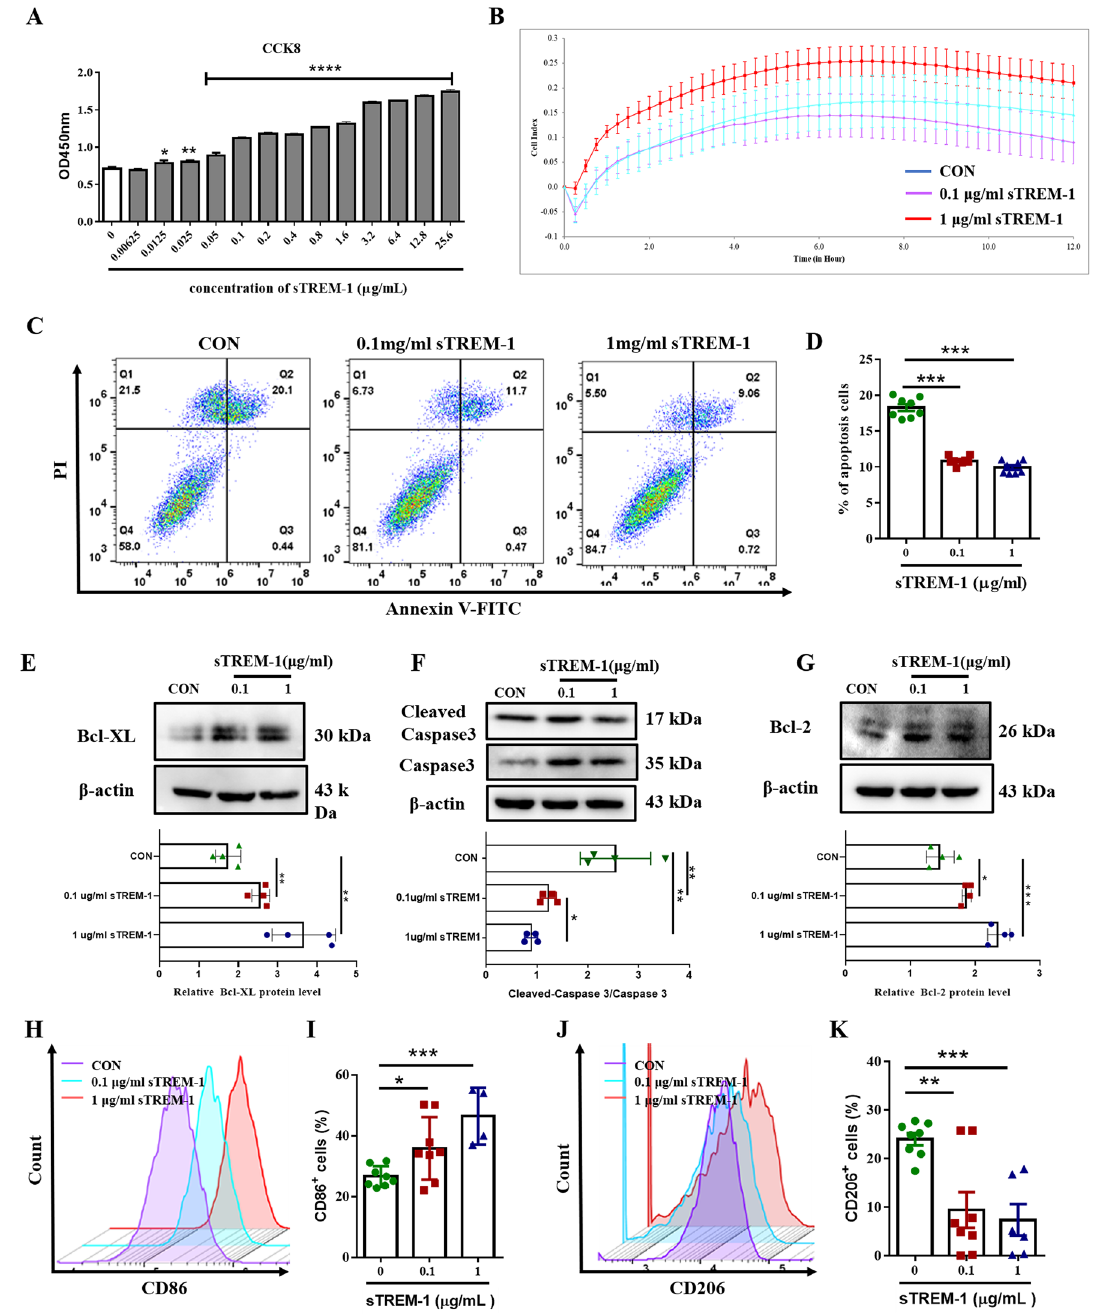
Figure 4. sTREM-1 promotes the activation of BV2 cells in vivo . (A) CCK-8 was used to detect the cytotoxicity of sTREM-1 on BV2 cells. (B) RTCA was used to detect the effect of sTREM-1 on the proliferation of BV2 cells in each treatment group. (C) Representative images of the apoptotic levels of BV2 cells in each treatment group were detected by flow cytometry. (D) The percentage of early apoptotic (Annexin V + PI + ) cells in each treatment group. (E) Representative western blot images and quantitative analysis of Bcl-XL protein expression levels of BV2 cells in each treatment group. (F) Representative western blot images and quantitative analysis of caspase-3 protein expression levels of BV2 cells in each treatment group. (G) Representative western blot images and quantitative analysis of Bcl-2 protein expression levels of BV2 cells in each treatment group. (H) Representative images of M1 phenotype (CD86 + ) in BV2 cells by flow cytometry detection. (I) Quantitative analysis of the proportion of CD86 + BV2 cells in each treatment group. (J) Representative images of M1 phenotype (CD206 + ) in BV2 cells by flow cytometry detection . (K) Quantitative analysis of the proportion of CD206 + BV2 cells in each treatment group; Data are presented as means ± SEM of at least three separate experiments. * P < 0.05, ** P < 0.01, *** P < 0.001, **** P <